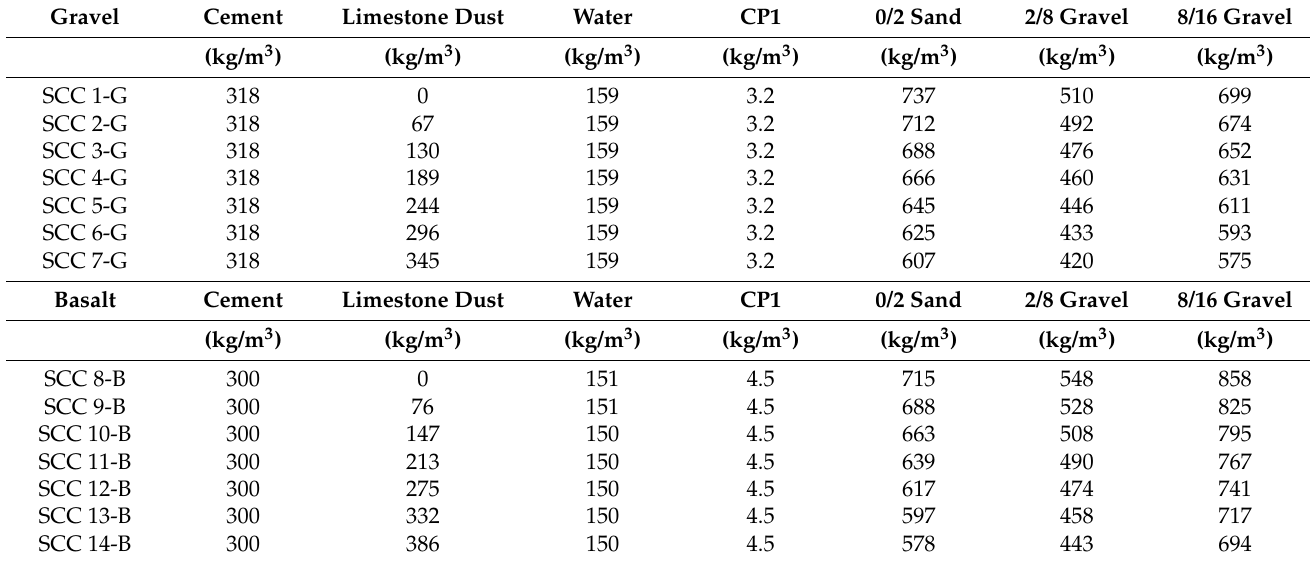
Table 13. Juxtaposition of recipe